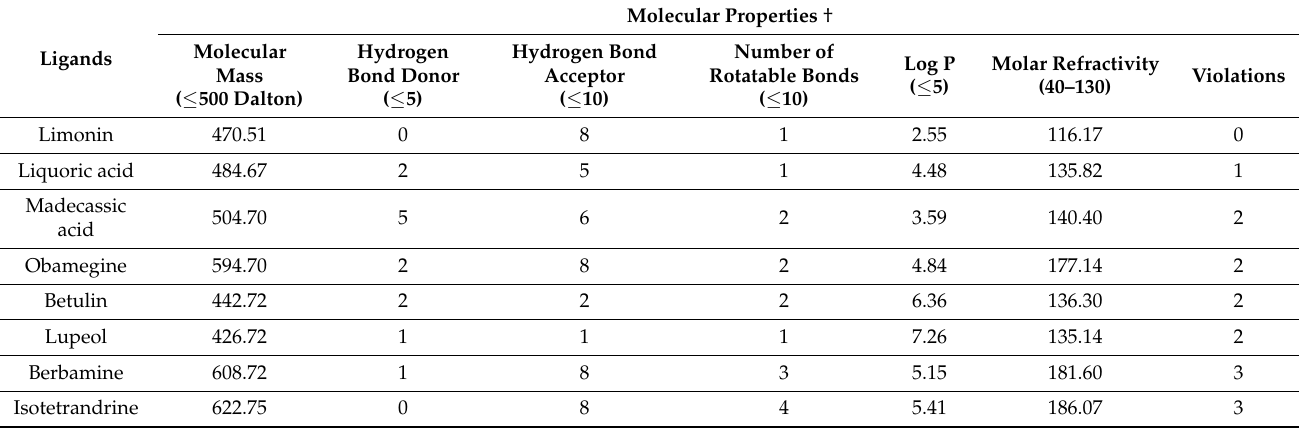
Table 2. Drug-like properties of the best-selected phytochemicals.